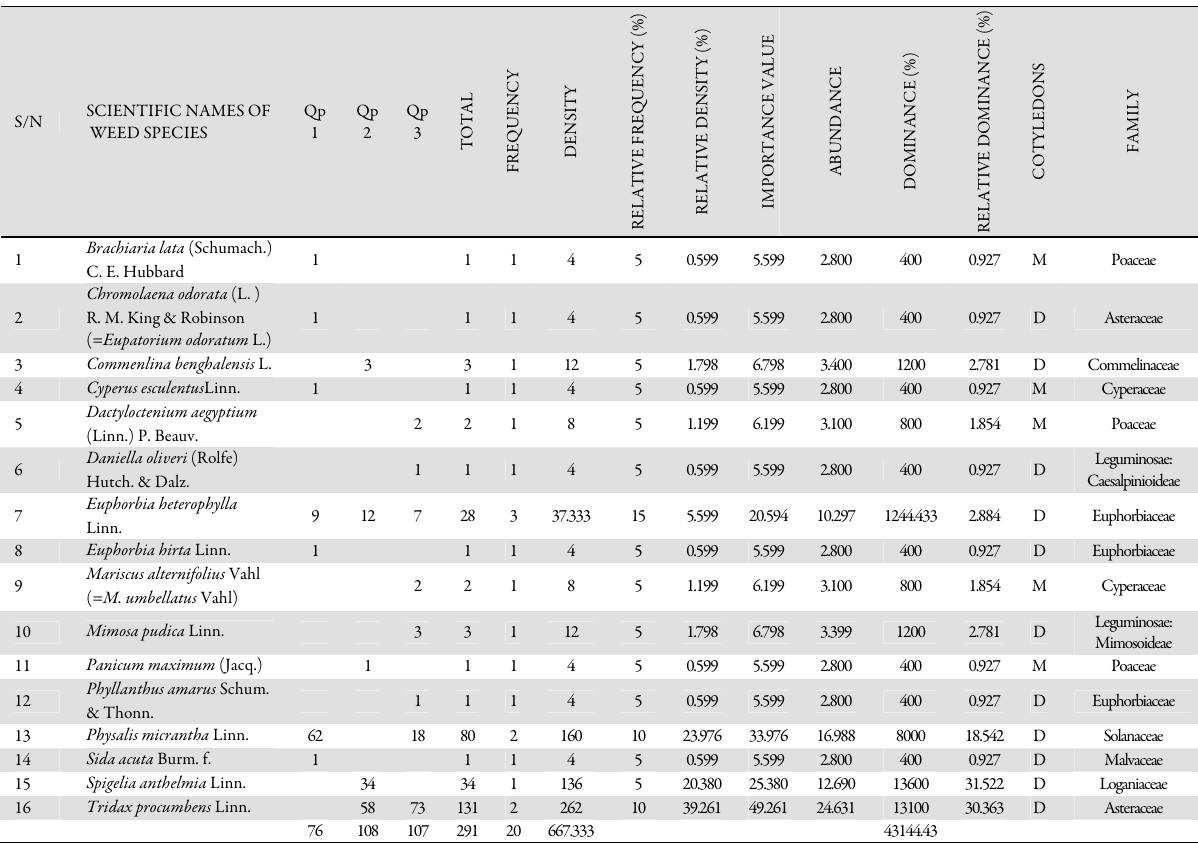
Tab. 5. Weed flora and species parameter for pepper plot at 3WAP